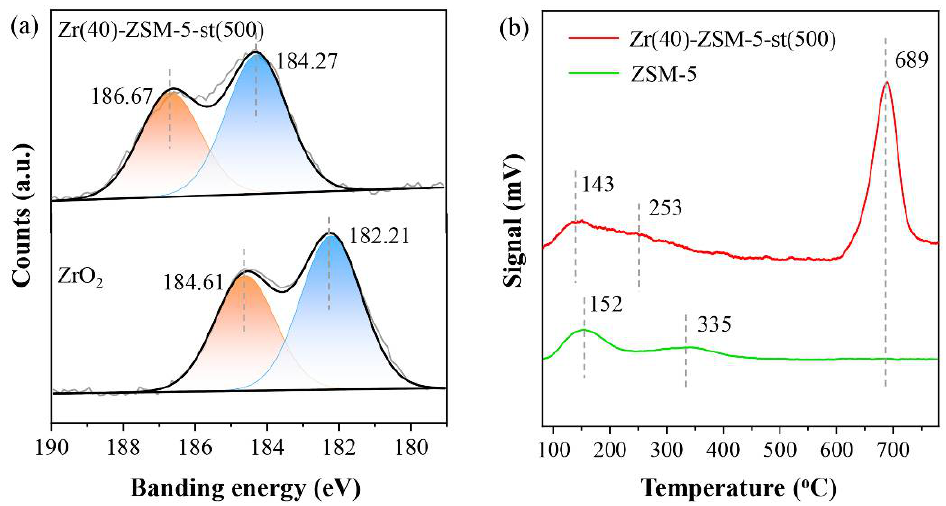
Figure 4. ( a ) Zr 3d XPS spectra for Zr(40)-ZSM-5-st(500) catalyst as well as ZrO 2 . ( b ) NH 3 -TPD spectra for Zr(40)-ZSM-5-st(500) together with ZSM-5 catalysts.